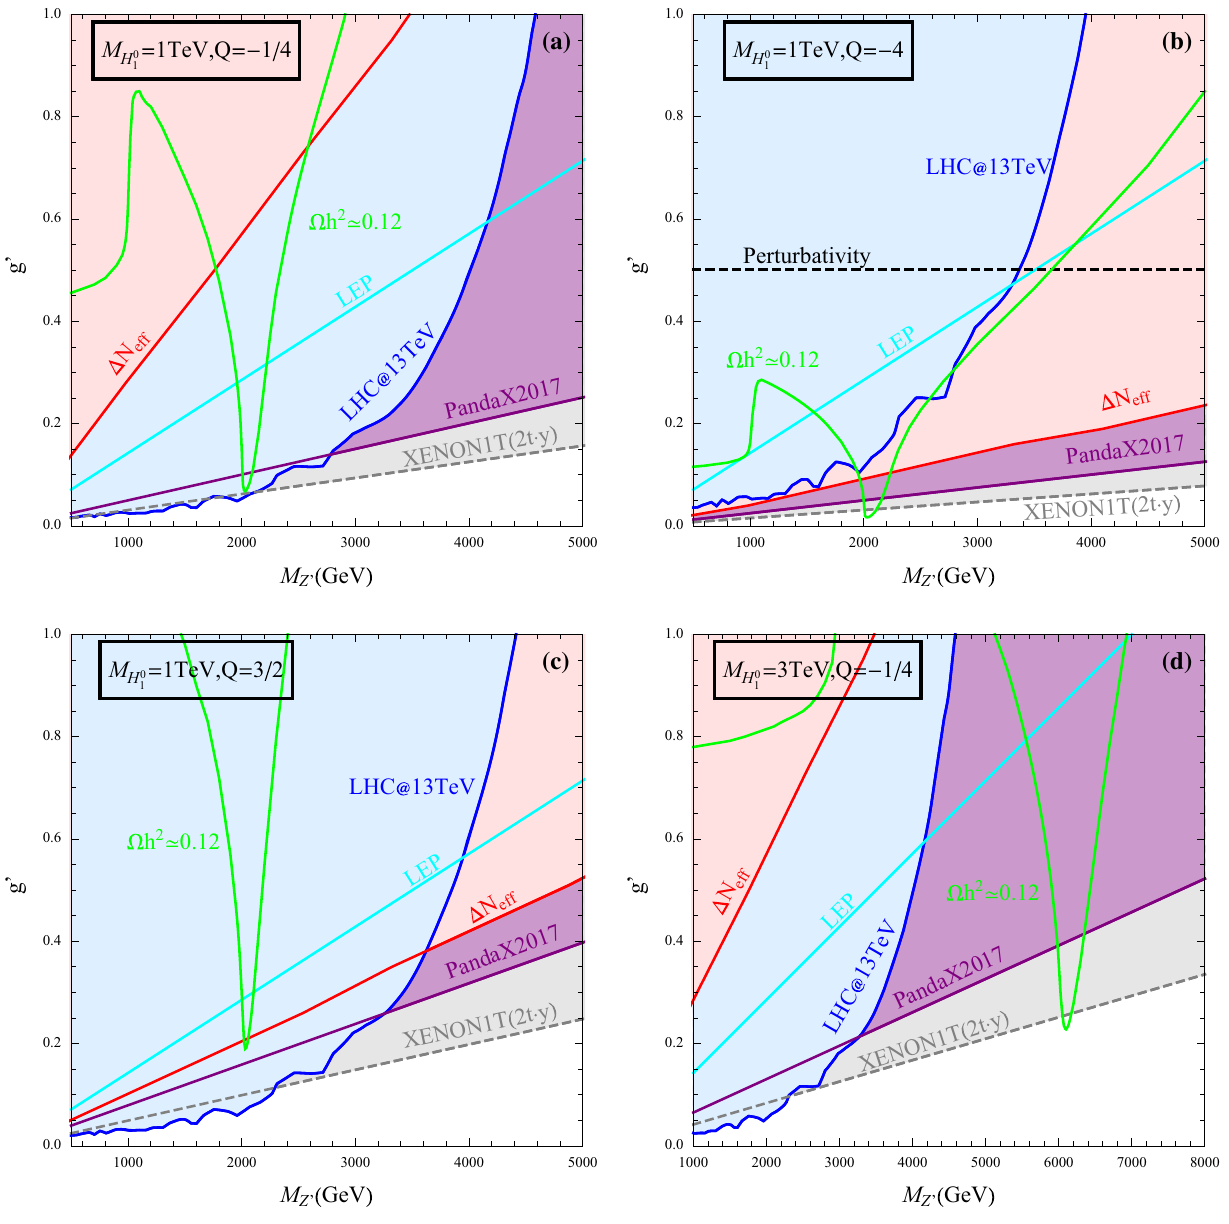
Fig. 12 Combined results in the g (cid:2) - M Z (cid:2) plane for scalar DM M . observable (cid:3) N eff (red) [74], direct detection limit from PandaX2017 H 0 1 (purple) [88] and future XENON1T(2t · y) (gray) [89]. With fixed DM = 1 TeV with Q = − 1 = 1 TeV with Q = − 4; a M ; b M H 0 1 H 0 1 4 mass and B − L charge Q , the green lines further satisfy relic density = 1 TeV with Q = 3 = 3 TeV with Q = − 1 c M ; d M . condition (cid:20) h 2 (cid:5) 0 . 12 [74]. To make sure the model is perturbative, we H 0 1 H 0 1 2 4 Experimental bounds are obtained from 13 TeV LHC dilepton signa- also require | g (cid:2) · Q max | < ture (blue) [60], LEP precise measurement (cyan) [53], dark radiation